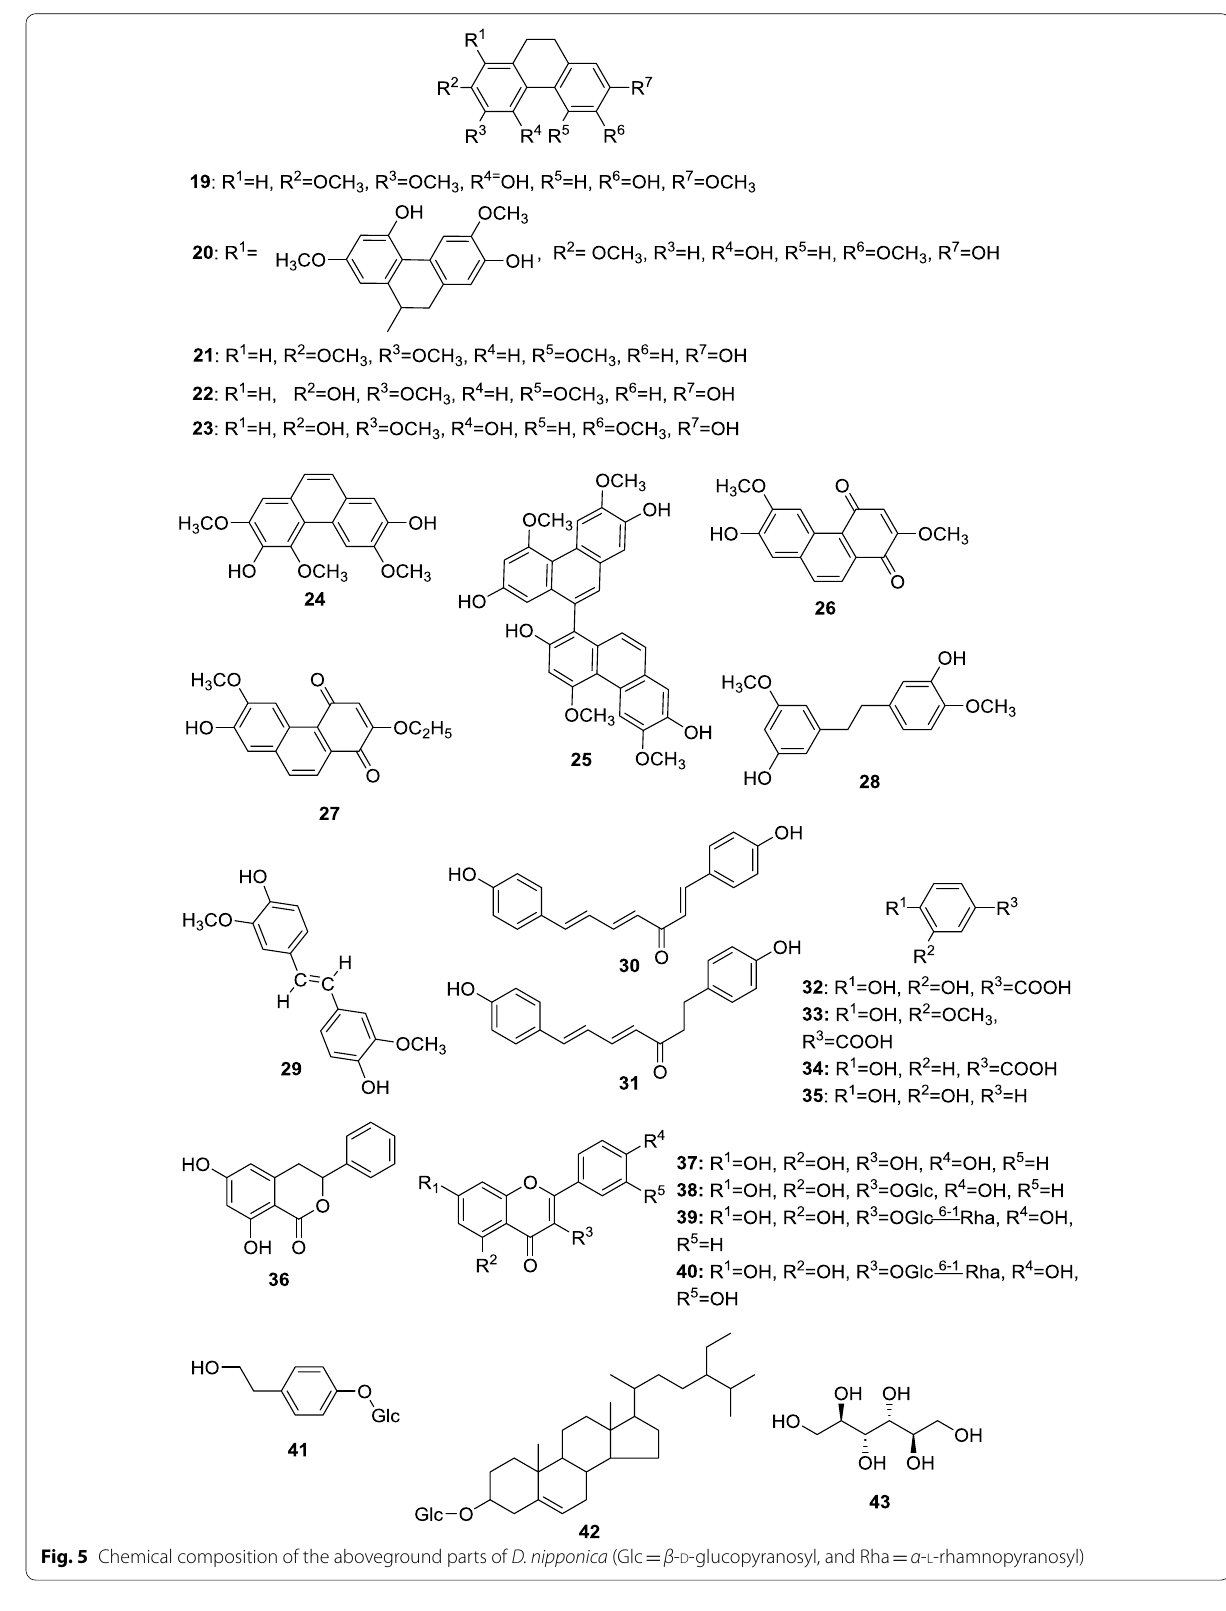
Fig. 5 Chemical composition of the aboveground parts of D. nipponica (Glc